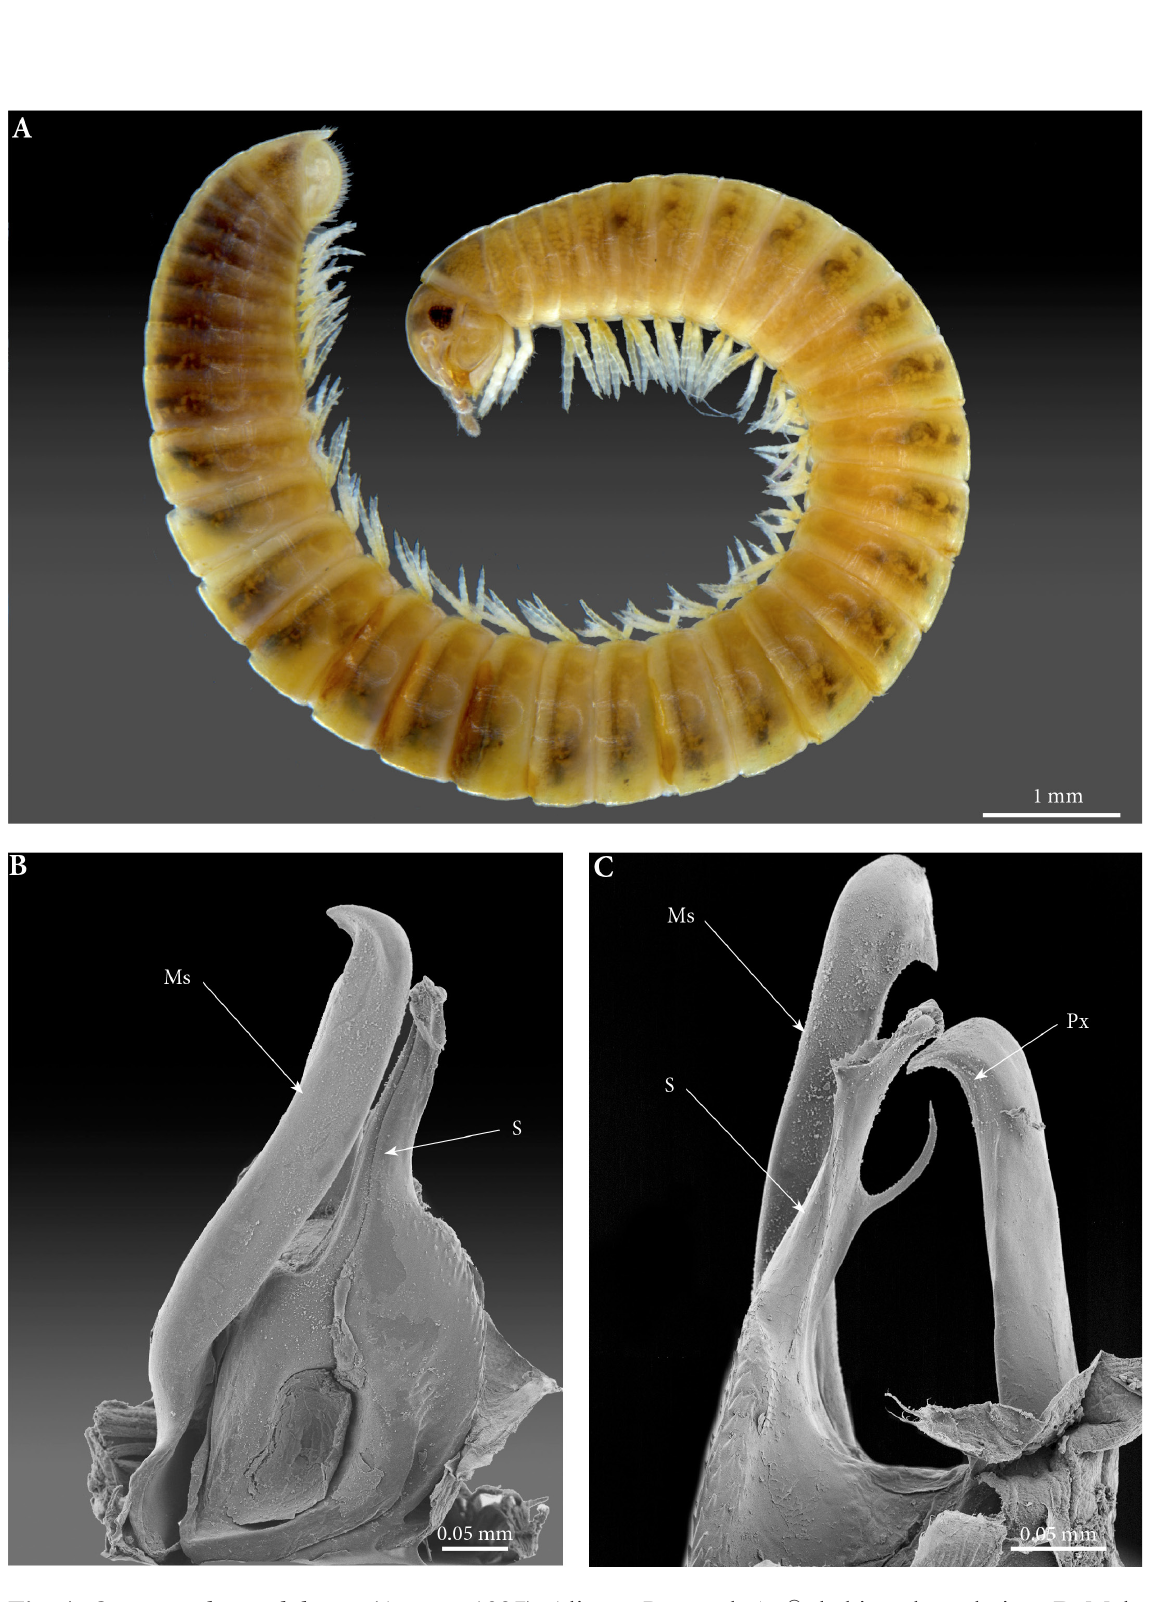
Fig. 4. Ommatoiulus andalusius (Attems, 1927), Aljezur, Portugal. A . ♀, habitus, lateral view. B . Male left posterior gonopod, mesal view. C . Male left posterior gonopod, posterior